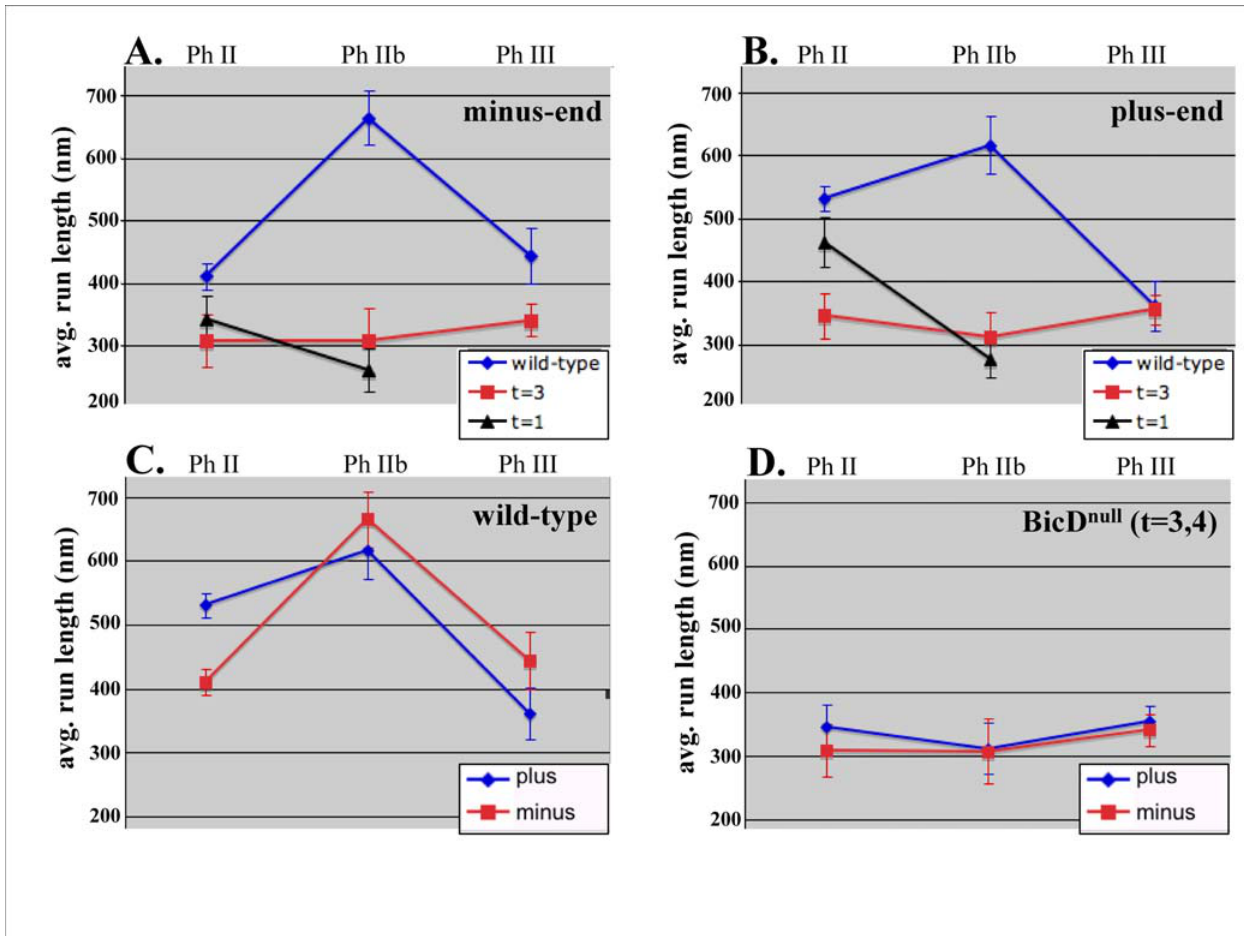
Figure 3. Droplet distribution is altered due to BicD-induced changes in Droplet motion. A: BicD contributes to correct minus-end motion. In the t=3,4 null background, minus-end directed run lengths are shorter in all three phases under consideration. While a clear run length peak is present in phase IIb of wild-type, there is no such peak in the null. B: Comparison of plus-end directed run lengths shows that BicD affects this direction of transport as well, although, not in phase III (B). Note the difference between t=1 and t=3 plus-end run lengths (t-test, p=0.049) in phase II (A). A similar difference is not apparent in the minus-end direction (t-test, p=0.56) of transport (B). C and D: The net reversal of directionality seen to occur in phase IIb for wild-type (C) does not occur in the mutant